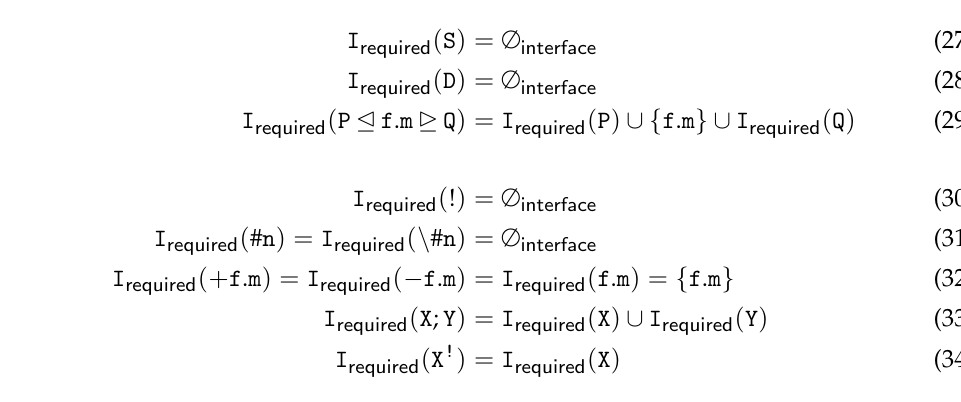
Table 2. Equations for the required interfaces of threads and instruction